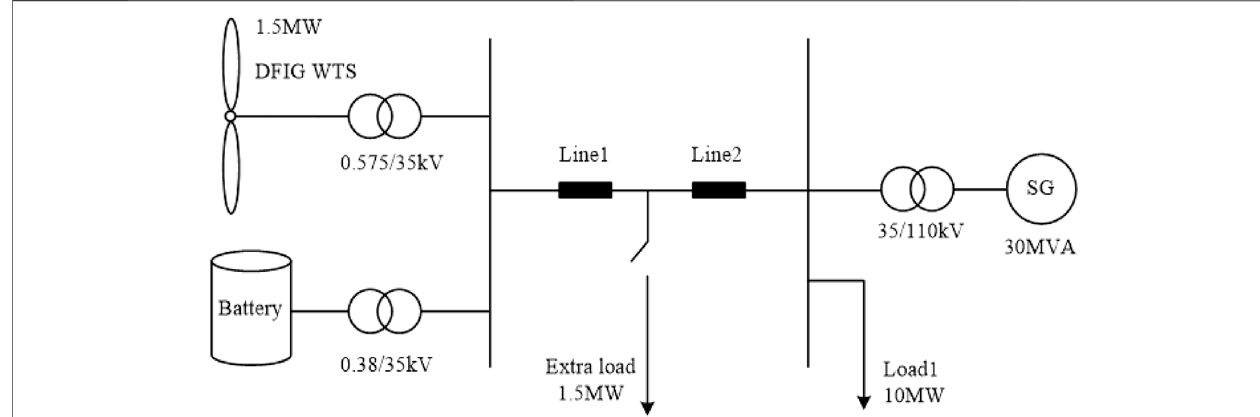
FIGURE 6 | Single-line diagram of the wind turbine generator – BESS hybrid